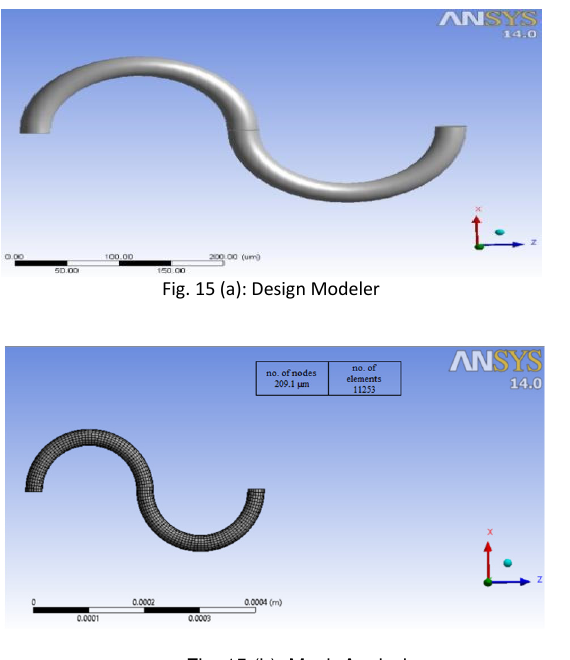
Fig. 15 (b): Mesh Analysis